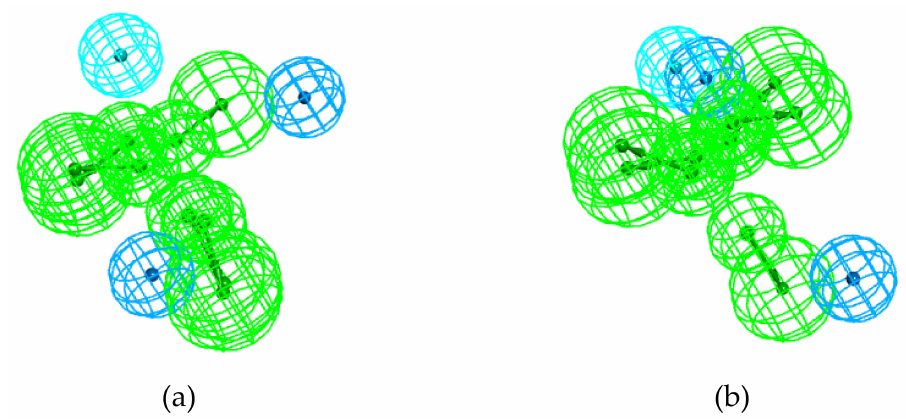
Figure 12. Pharmacophore mappings of Hypo1_t-CAR and Hypo1_t-PNA ( a ) without a tether and ( b ) after tethering hydrophobic features Hy (Hypo1_t-CAR) and Hy-al1